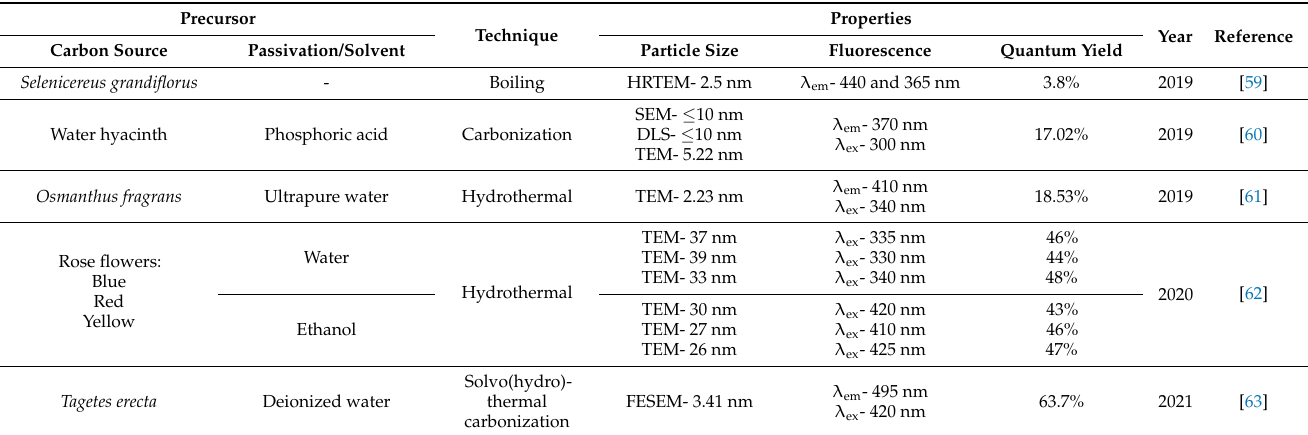
Table 3. Summary of the synthesis of CDs from